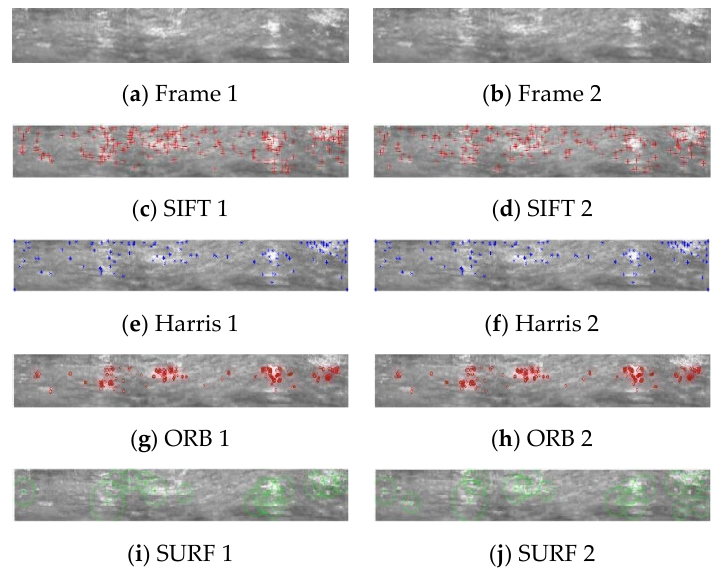
Figure 5. Feature points extraction results of 2 consecutive borehole unfolded images. ( a ) Borehole image 1 and ( b ) borehole image 2. ( c , e , g , i ) contain the SIFT, ORB Harris, SURF feature points of borehole image 1, and ( d , f , h , j ) contain the SIFT, ORB Harris, SURF feature points of borehole image 2. Table 1. Number of feature points and running time.